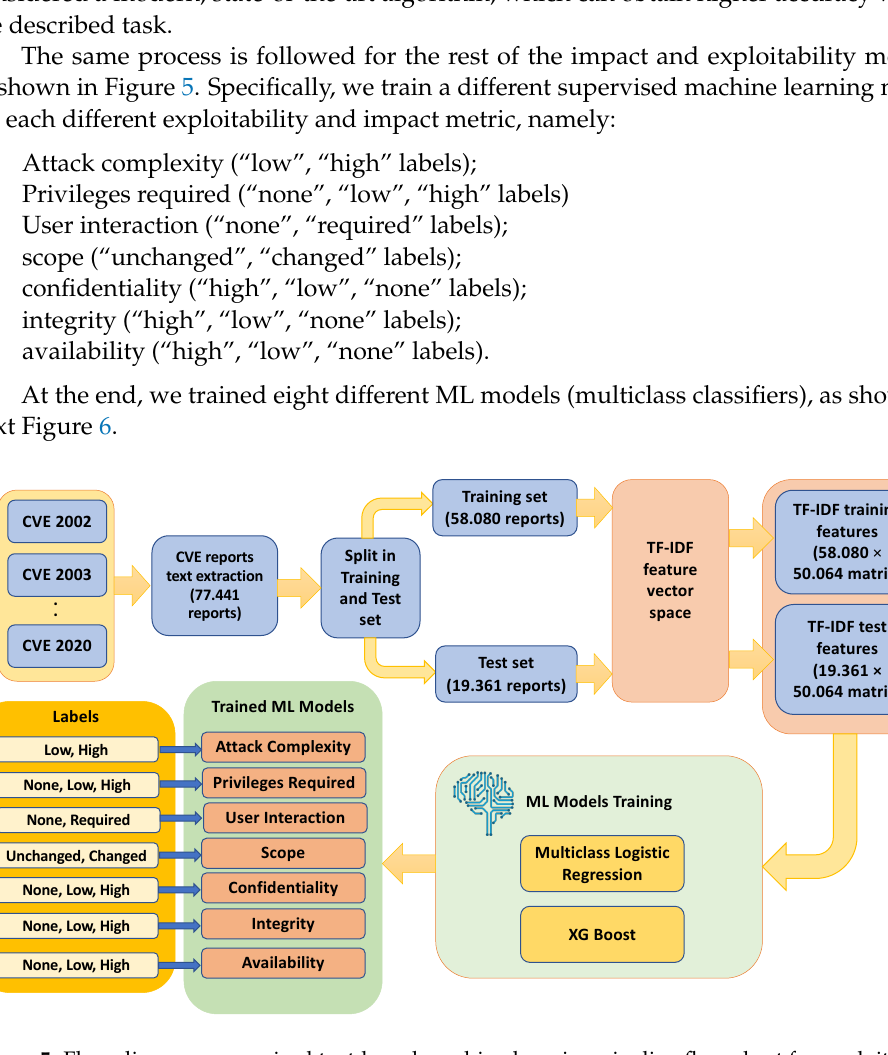
Figure 5. Flow diagram supervised text-based machine learning pipeline flow chart for exploitability and impact